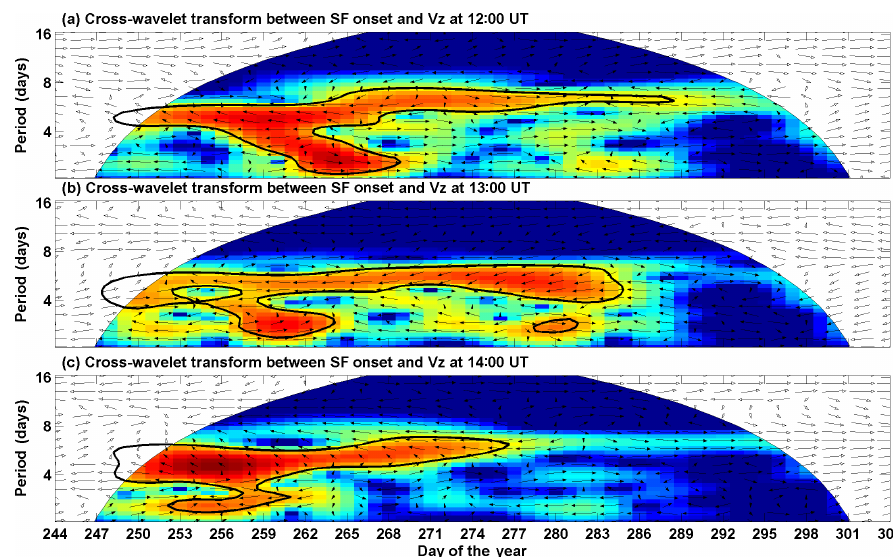
Figure 5. The cross-wavelet transform between the SF onsets and the vertical drifts (Vz) at 12:00UT (a) , 13:00UT (b) and 14:00UT (c) . The black border lines (parabolic curves opening downward) denote the cone of influence (COI) for the beginning and end of the data sets. The short black arrows denote the phase difference between the two time series with in-phase pointing right, antiphase pointing left and Vz leading SF onset by 90 ◦ pointing vertically upwards.